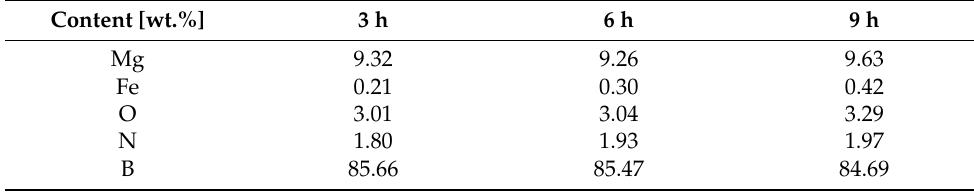
Table 1. The content of Mg/B1 composite powders cryomilled for 3 h, 6 h, and 9 h. Content [wt.%]